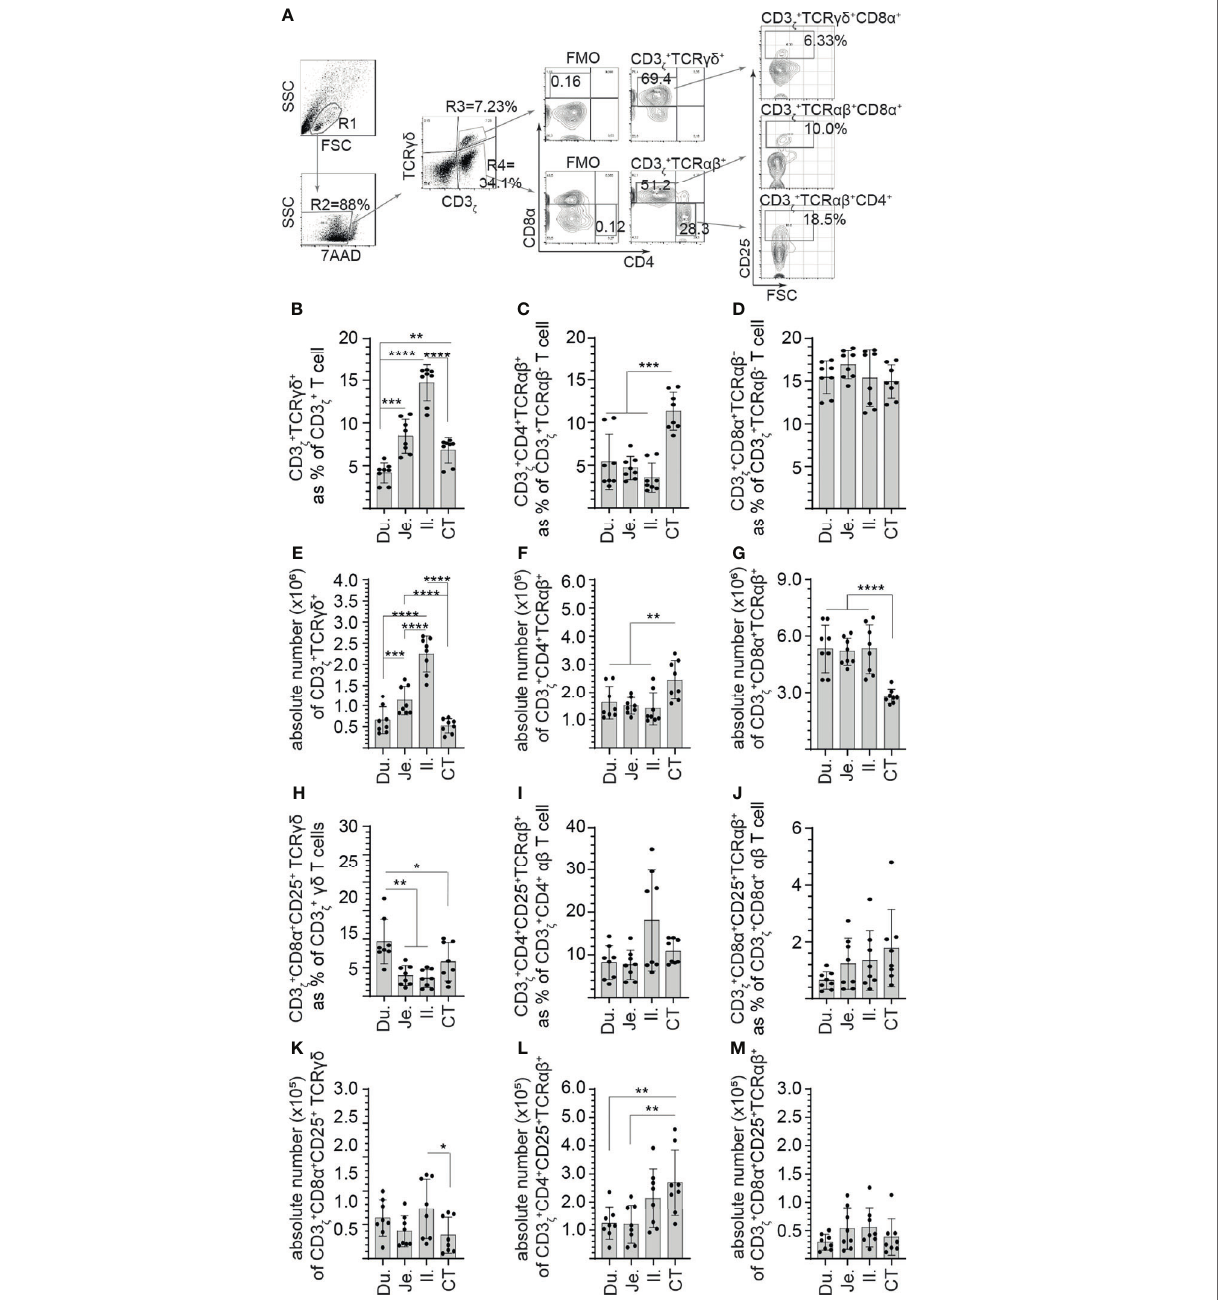
FIGURE 2 | Site-speci fi c differences in the frequency of CD3+ and CD25+ mononuclear cells along the avian small intestine. Small intestine mononuclear cells were isolated from the duodenum, jejunum, ileum, and cecal tonsils of 3-week-old layer chickens ( n = 8). Live cells were de fi ned based on 7-aminoactinomycin D staining (7AAD-). (A) Dot plots demonstrating the gating strategy utilized to de fi ne the frequency of (B) CD3 z +CD8 a + gd T cells, (C) CD3 z +CD4+ ab T cells, (D) CD3 z +CD8 a + ab T cells (H) CD3 z +CD8 a +CD25+ gd T cells (I) CD3 z +CD4+CD25+ ab T cells, and (J) CD3 z +CD8 a +CD25+ ab T cells in the duodenum, jejunum, ileum, and cecal tonsil. Absolute numbers of (E) CD3 z +CD8 a + gd T cells, (F) CD3 z +CD4+ ab T cells, (G) CD3 z +CD8 a + ab T cells (K) CD3 z +CD8 a +CD25+ gd T cells (L) CD3 z +CD4+CD25+ ab T cells, and (M) CD3 z +CD8 a +CD25+ ab T cells in the duodenum, jejunum, ileum, and cecal tonsil. Paired t -test was used to assess normal distribution and test signi fi cance. * p < 0.05, ** p < 0.001, *** p < 0.0005, and **** p < 0. 0001 indicated a statistically signi fi cant difference. NS indicates no signi fi cant difference. The mean ± SD value are shown from six individual layer chickens at 3 weeks of age with staining performed in triplicates Du, duodenum; Je, jejunum; Il, ileum; CT, cecal